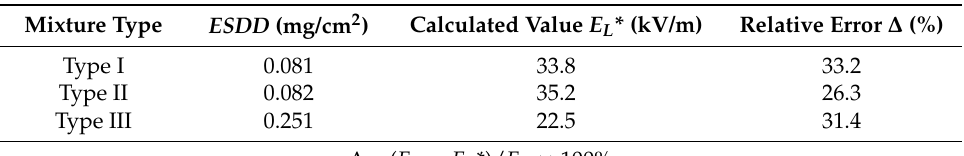
Table 7. Test results of insulator strings polluted with three types of soluble constituents mixture, E L * means the calculated value of flashover